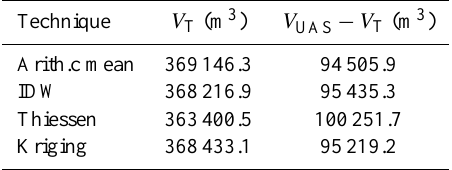
Table 3. Comparison between the snow volume via UAS V UAS = 463652 . 3m 3 and the one obtained via spatialization techniques ( V T